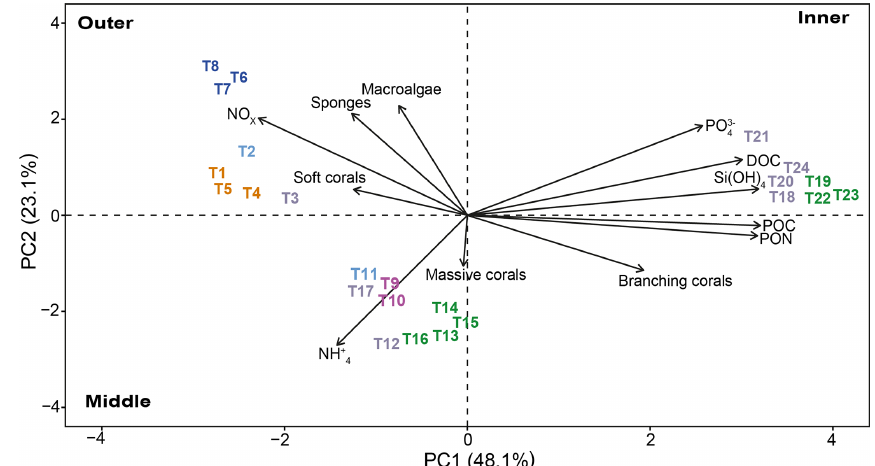
Figure 11. Principal component analysis (PCA) between benthic community (macroalgae, sponges, corals, branching corals, and massive corals) data and environmental parameters (PON, POC, DOC, Si ( OH ) 4 , PO 3 − length of the vectors indicates the contribution of each parameter. The first dimension explains 48.1% of the variance, and the second dimension explains 23.1% of the variance. Colors refer to the cluster subdivision (Fig.